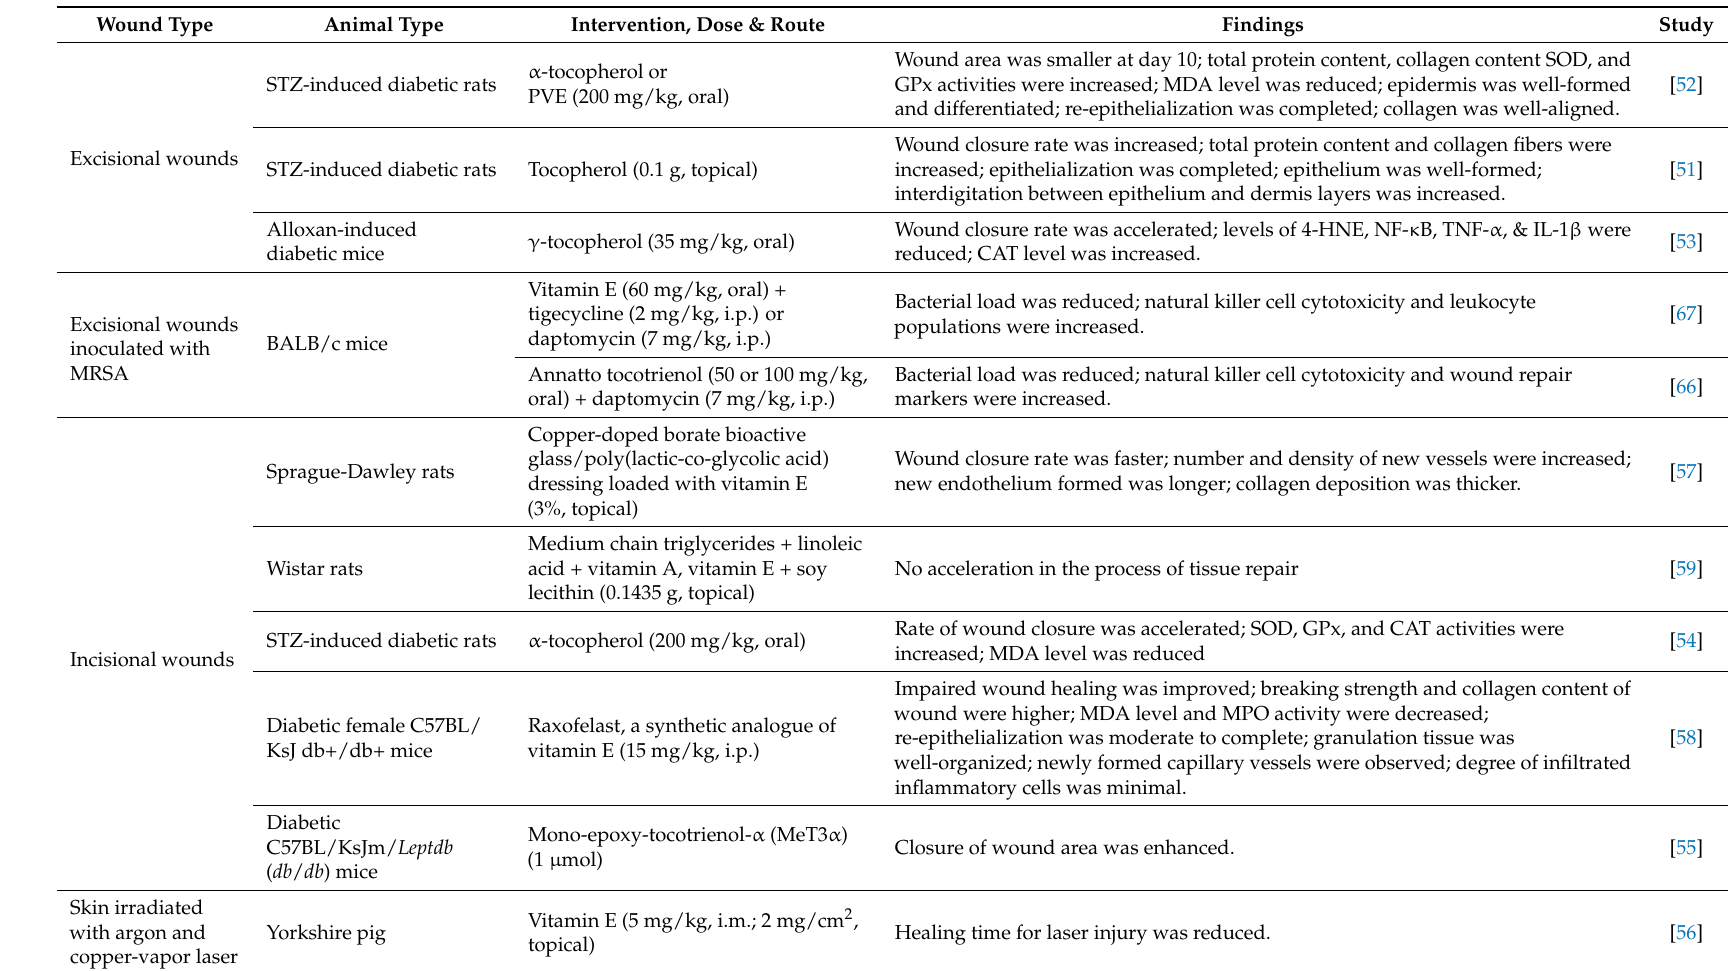
Table 2. The effects of vitamin E on wound healing in animal